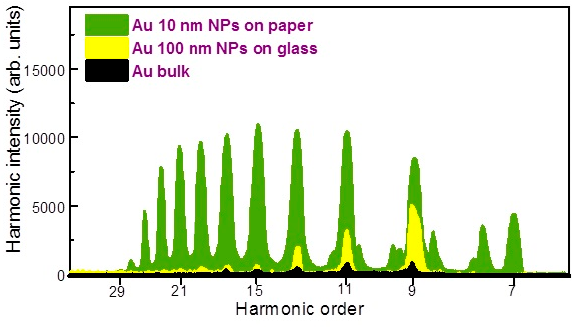
Figure 3. Comparative harmonic spectra from ablated bulk Au (at 200 ns delay), Au 100 nm NPs (at 200 ns delay), and Au 10 nm NPs on paper (at 350 ns delay).